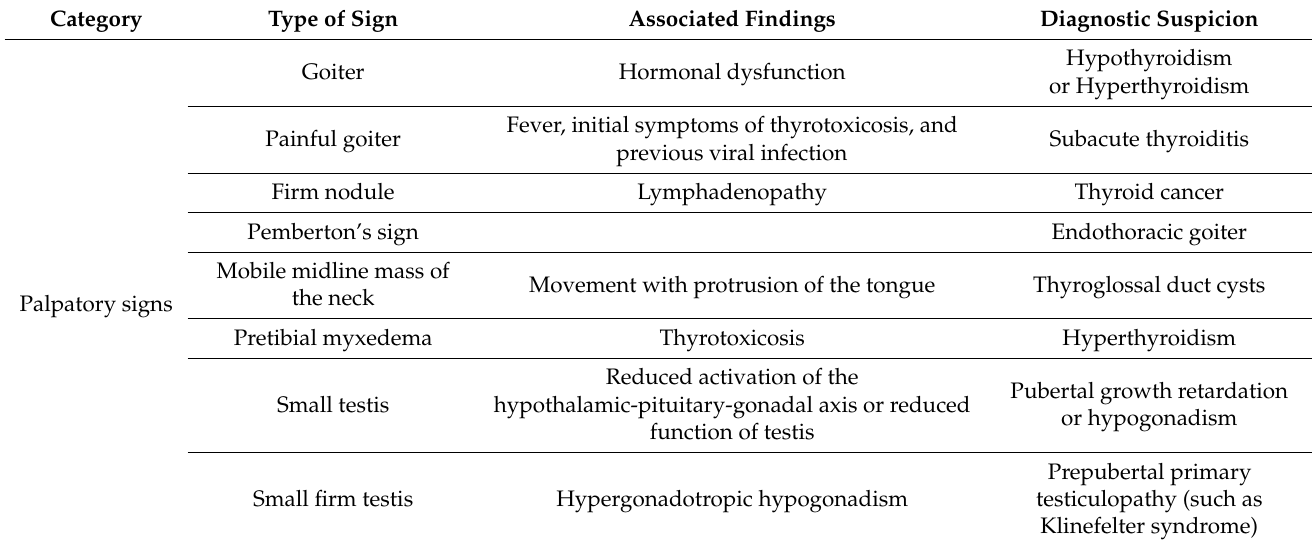
Table 1. Main physical signs in the clinical evaluation of patients with endocrine/metabolic diseases and their possible diagnostic